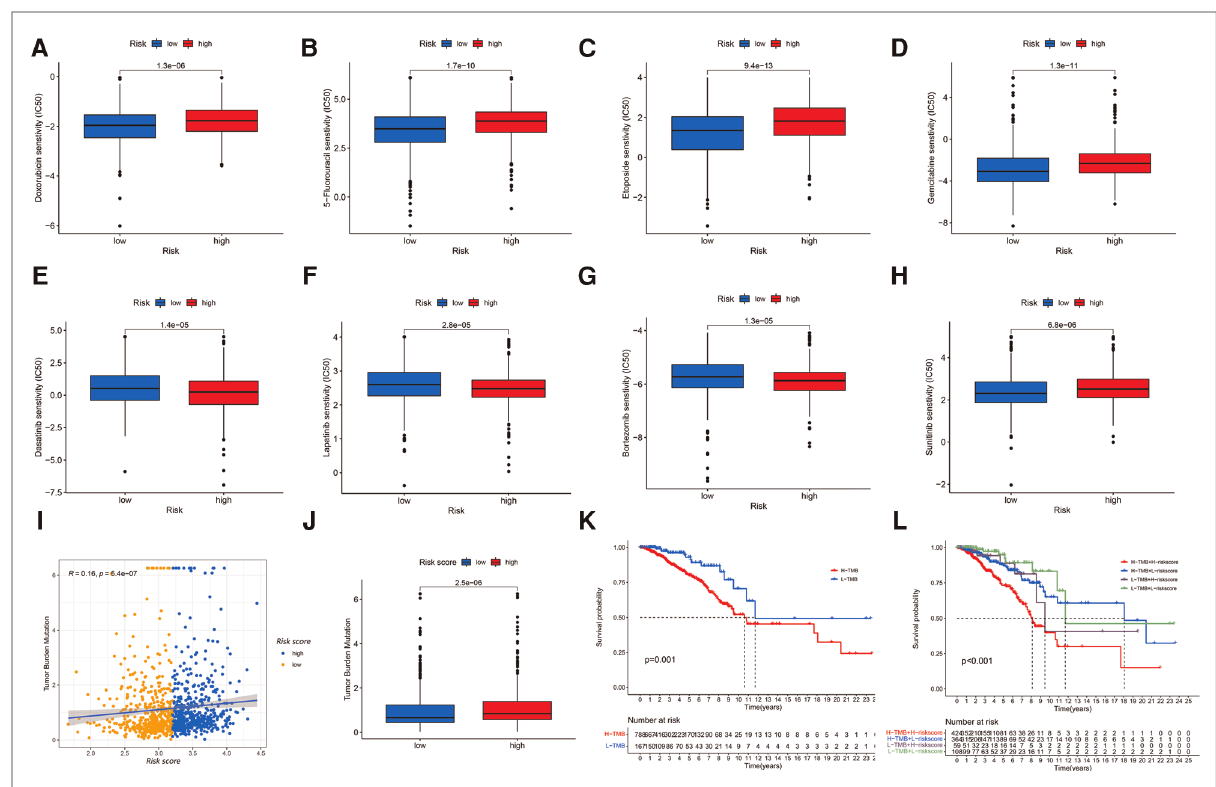
FIGURE 7 The GRG signature in the role of antineoplastic therapy, including ( A ) doxorubicin, ( B ) 5- fl uorouracil, ( C ) etoposide, ( D ) gemcitabine, ( E ) dasatinib, ( F ) lapatinib, ( G ) bortezomib and ( H ) sunitinib. ( I,J ) Correlations and difference of TMB between high-risk and low-risk groups. ( K ) Survival probability for patients between high-TMB and low-TMB groups. ( L ) Survival probability for patients combining TMB with risk